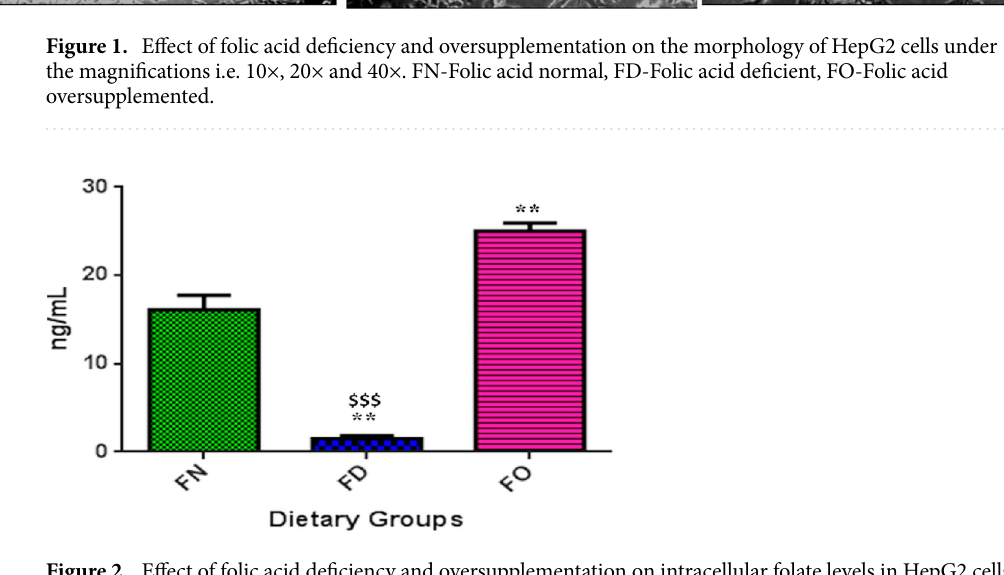
Figure 2. Effect of folic acid deficiency and oversupplementation on intracellular folate levels in HepG2 cells. ** P < 0.01 versus FN, $$$ P < 0.001 versus FO; FN-Folic acid normal, FD-Folic acid deficient, FO-Folic acid